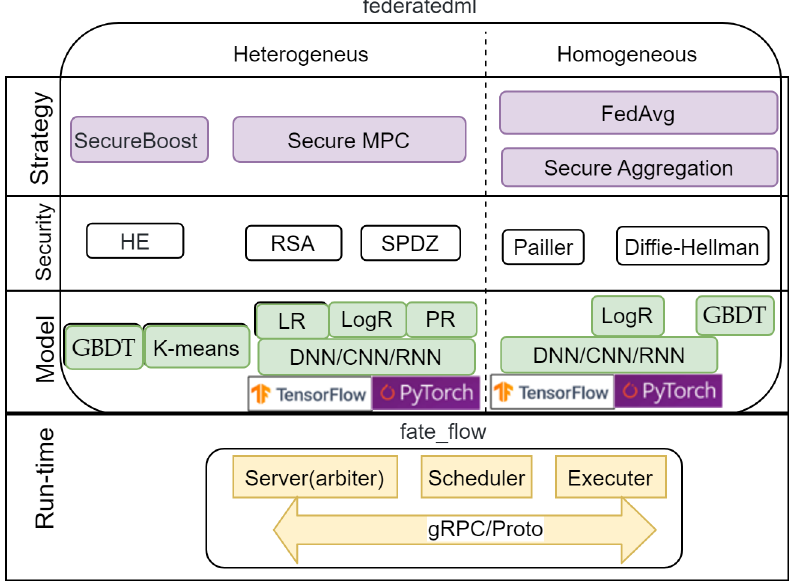
Figure 5. Architecture of Federated AI Technology Enabler